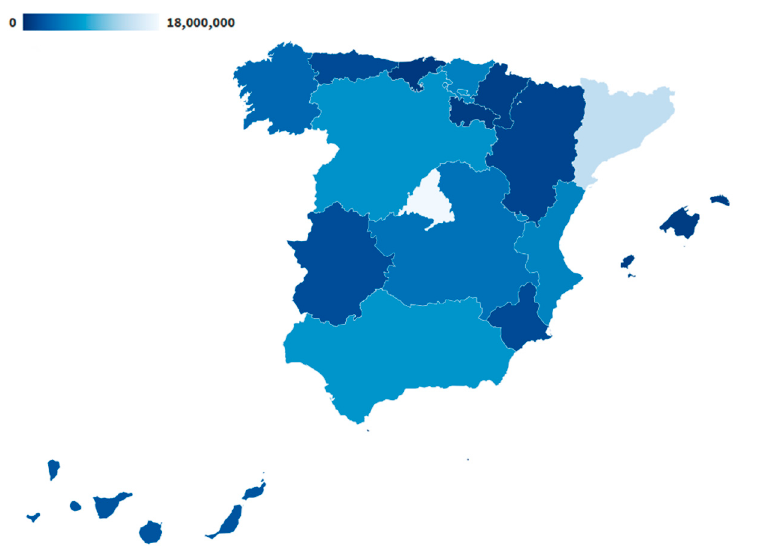
Figure 2. Masks that the Spanish Government has distributed to each autonomous community from March 10 to May 29 [24].